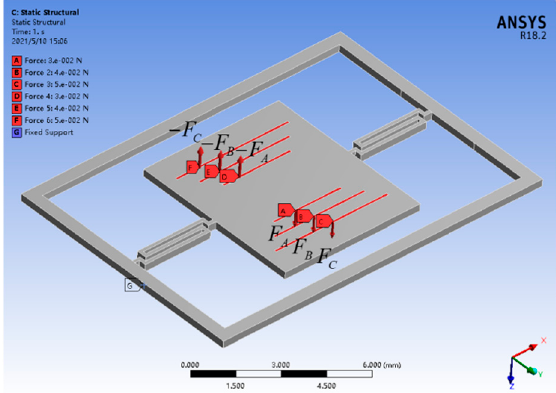
Figure 2. Simulation setting diagram of the ISM.